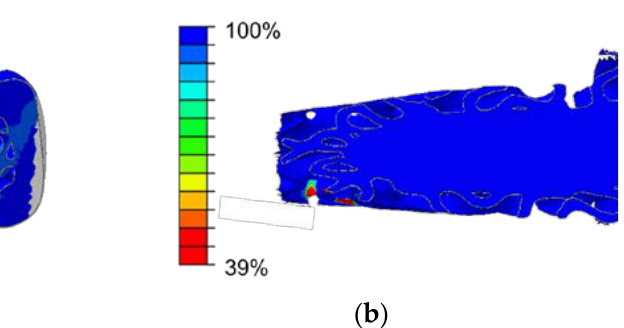
( b ) Figure 15. Index finger implant in proximal bone: ( a ) cut view of maximal principal stress in the implant; ( b ) Cut view of von Mises equivalent stress in the bone. However, first steps can be taken and the change of the load in the implant can be calculated via variation of the bone elasticity. Implant stress and bone elasticity are not linearly coupled, but the load increases significantly with decreasing bone modulus, ac- cording to the increasing proportion of the load balance under bending (Figure 16).